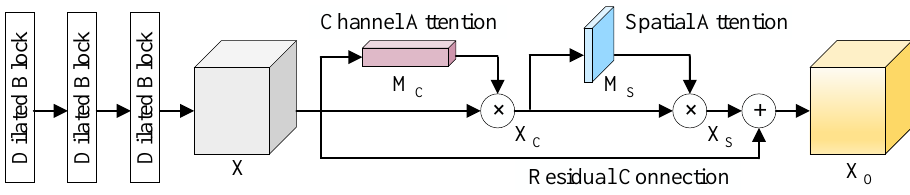
Figure 2. Dilated attention module (DAM) architecture.